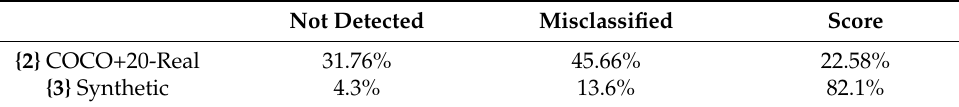
Table 4. Application-oriented metric results, comparing {2} and {3}